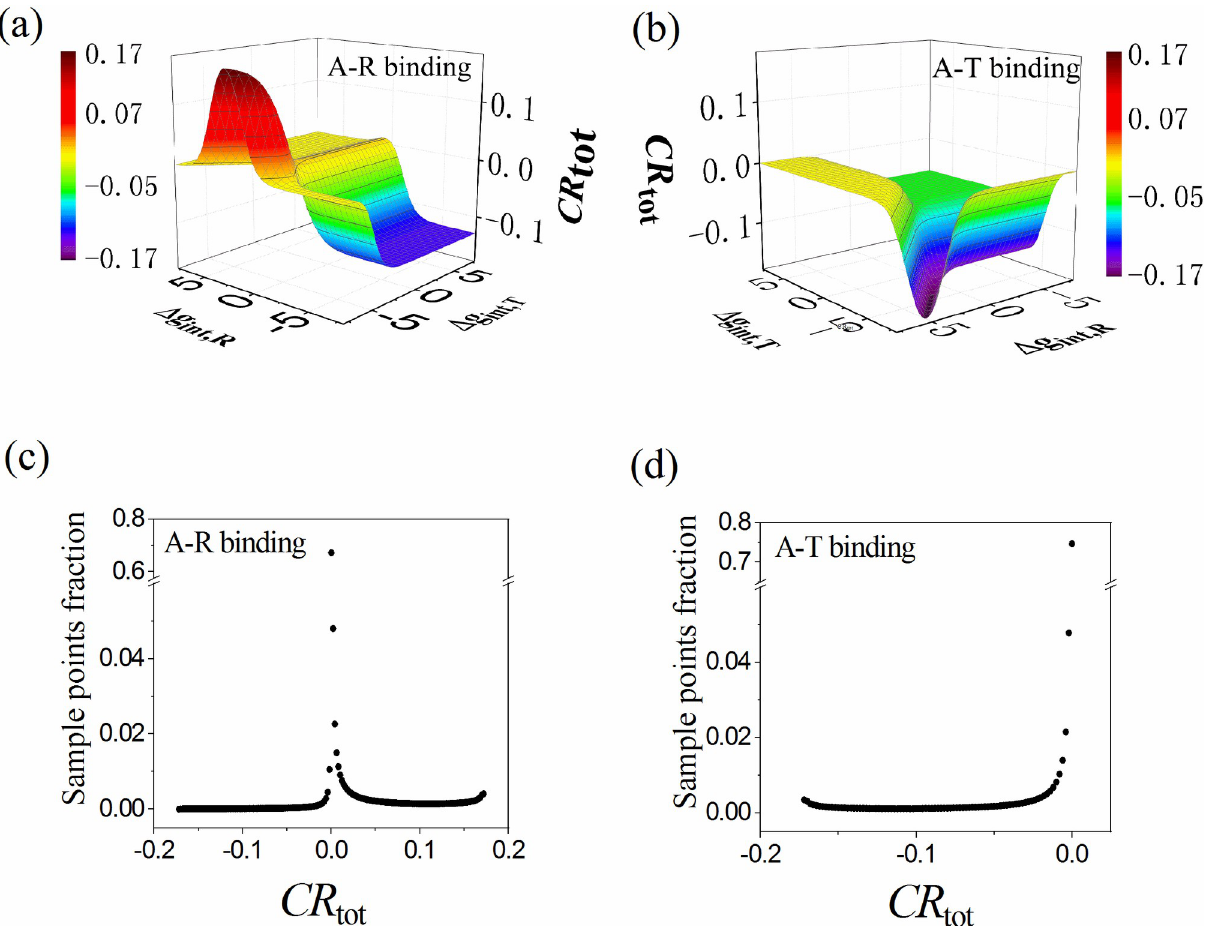
Fig 4. The allosteric coupling response ( CR ) of the comprehensive ensemble model. (a,b) CR as a function of Δ g int,R and Δ g int,T (in kcal/mol) when the other parameters are fixed (chosen to produce notable allostery) as: Δ G R1 = − 1.0, Δ G R2 = 1.3, Δ G RT1 = 1.0, Δ G RT2 = 3.0 (all in units of kcal/mol). Note that for A-T binding mode there is no activated allosteric effect. (c,d) Distribution of CR when the stability free-energy parameters ( Δ G R1 , Δ G R2 , Δ G RT1 , Δ G RT2 , Δ g int,R , Δ g int,T ) vary randomly with an equal probability density between − 8 and +8 kcal/mol. The A-R binding mode is adopted in (a,c) and the A-T binding mode is adopted in (b,d) with Δ g Lig,A = − 3 cal/mol.